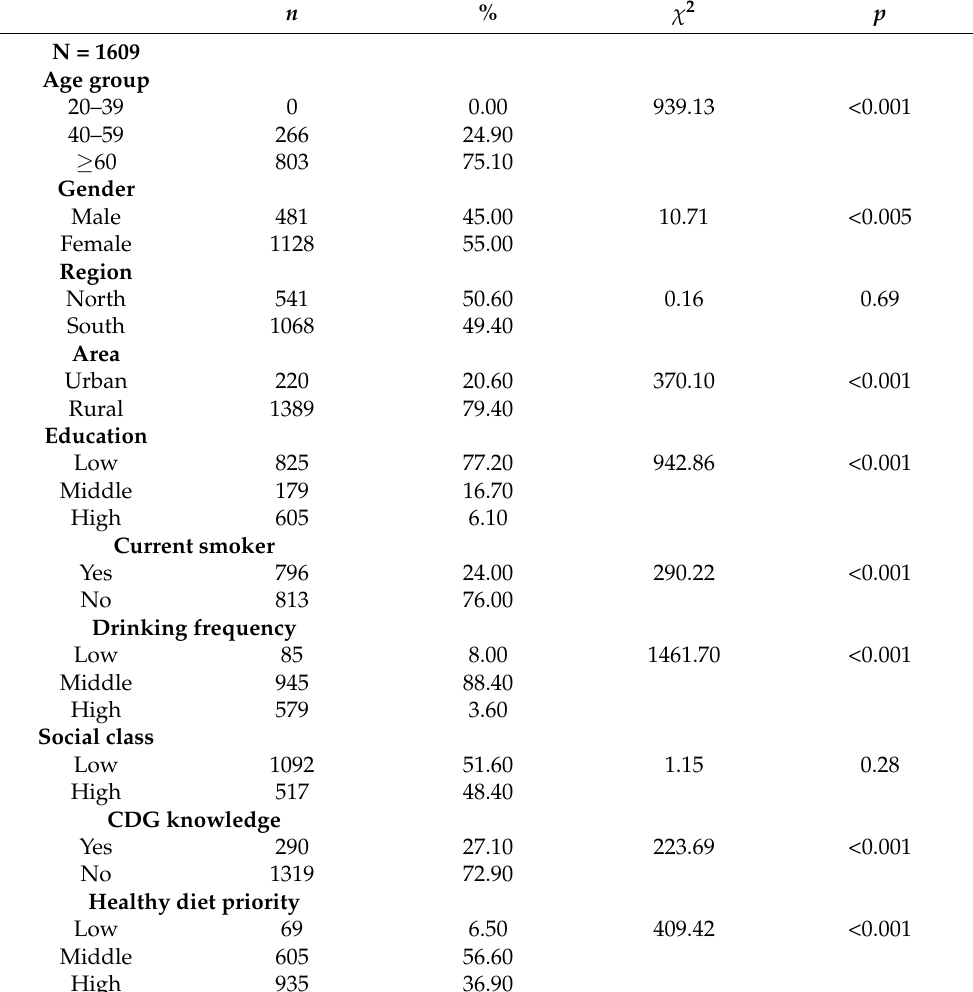
Table 2. Demographic characteristics and chi-square tests of adults who simultaneously met the DRI for all three